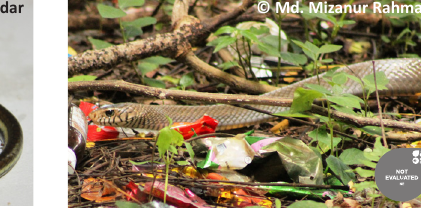
14. Dendrelaphis pictus Painted Bronze-back Tree Snake